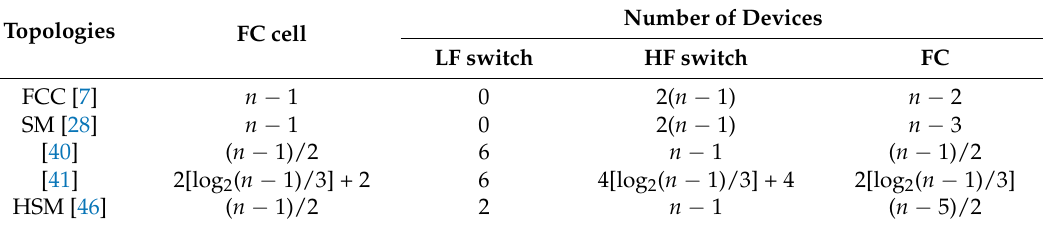
Table 4. Comparisons of n -level FC-based multilevel converters.